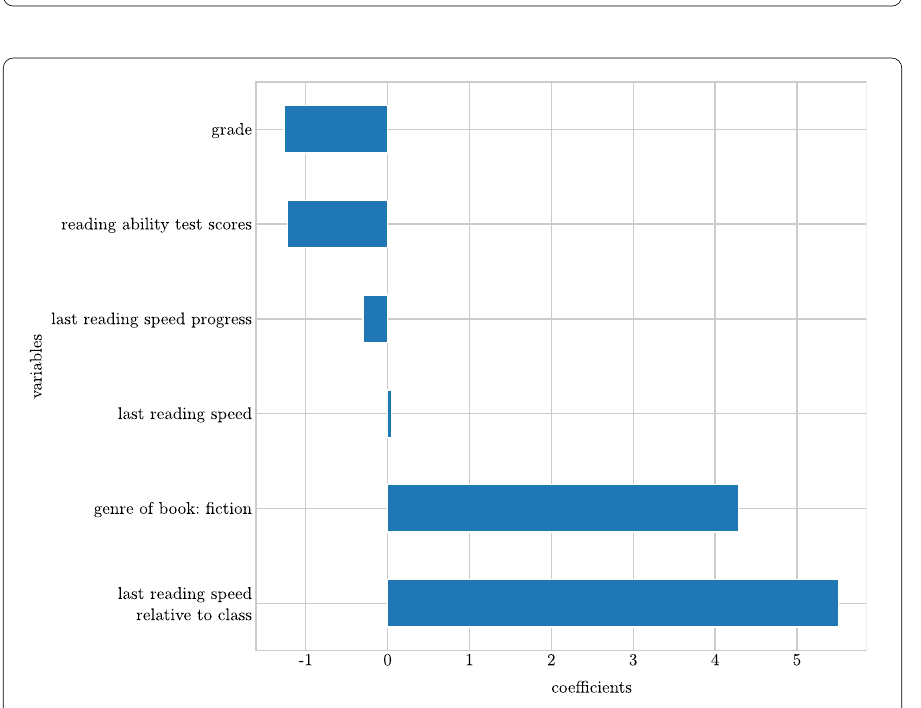
much progress in terms of reading speed. Finally, students that reads fast relative to the peers in the class are associated with the largest reading speed progress